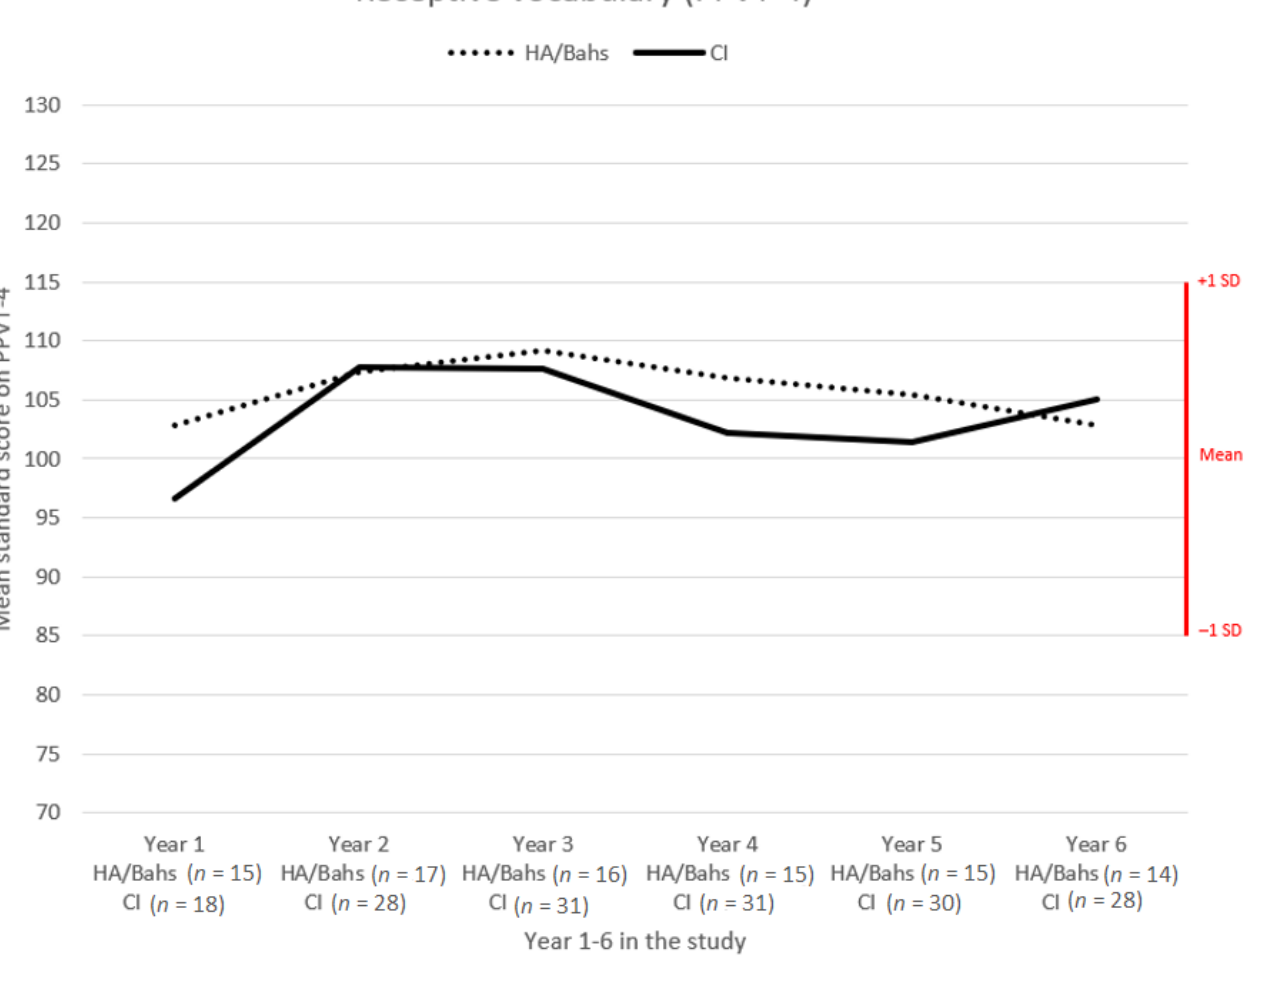
Figure 2. Comparison of mean standard scores on PPVT-4 of children with different devices over the 6-year project period.